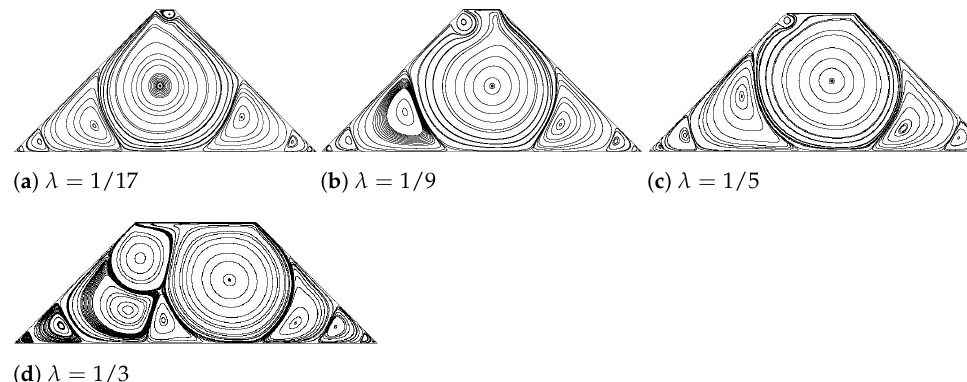
Figure 12. Streamlines inside the pyramid-shaped trapezoid with various values of λ at Re = 7000.